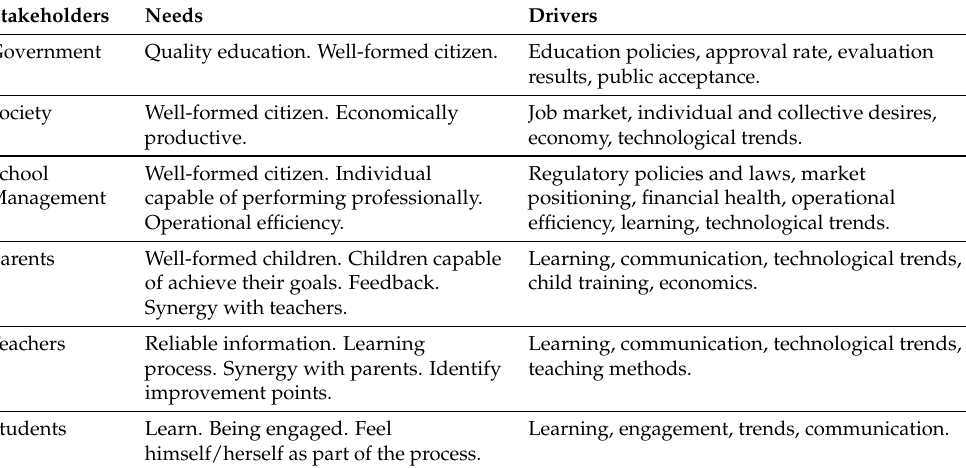
Table 3. Stakeholders and educational governance drivers.